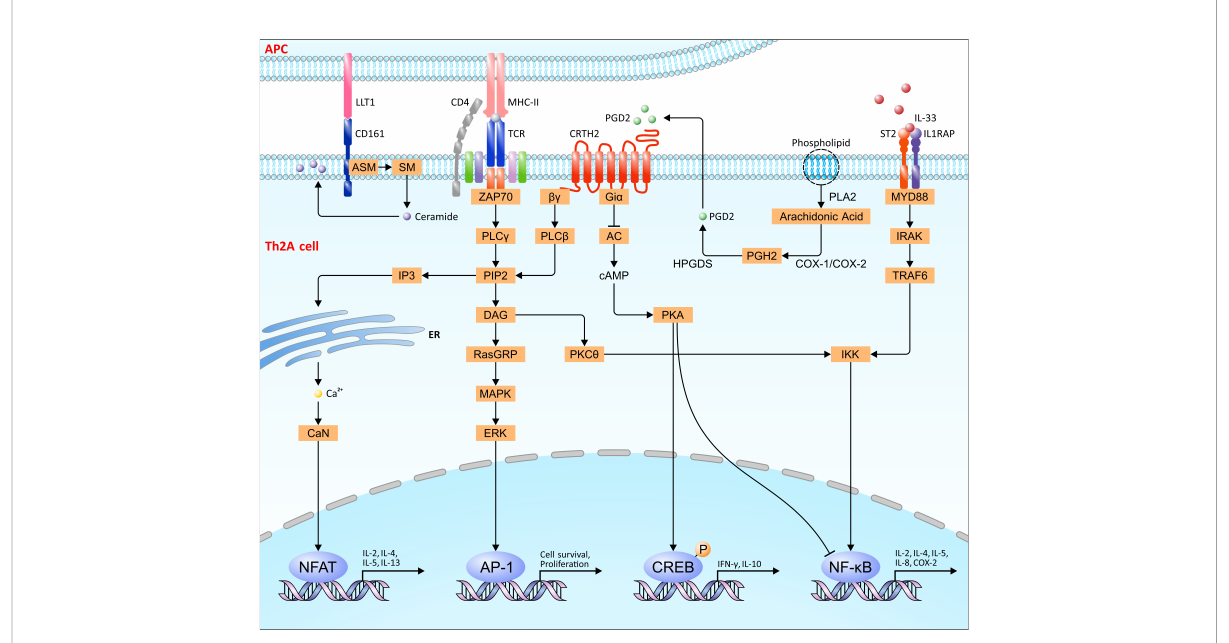
FIGURE 1 The signaling pathway of Th2A cells. The interaction of ST2 with IL-33 recruits MYD88 to activate TRAF6 by IRAK, leading to the activation of NF-kB released from the IKK complex. After CD161 combination with LLT1, aSMase is recruited to catalyze SM into ceramide, resulting in the aggregation in the membrane and inside the cells to mediate distinct functions. CRTH2 activated by PGD2 reduces cAMP production, thereby inhibiting NF- k B activity and phosphorylates CREB protein. Meanwhile, the same as TCR, CRTH2 also activates PKC q , ERK/MAPK, and Ca2 + calcineurin signaling pathways to mediate cell survival, proliferation, and cytokine production through the transcription factor NF- k B, AP-1, and NFAT. Arachidonic acid derived from phospholipids is converted to PGH2 by COX-1/2, which can then be catalyzed into PGD2 by HPGDS. IKK, I k B kinase; ZAP70, z -chain associated protein kinase of 70 kDa; PLC g , phospholipase C g ; PIP2, phosphatidylinositol bisphosphate; DAG, diacylglycerol; PKC q , protein kinase C q ; RASGRP, RAS guanyl nucleotide – releasing protein; MAPK, mitogen-activated protein kinase; ERK, extracellular signal-regulated kinase; IP3, inositol trisphosphate; cAMP, cyclic adenosine 3, 5 ′ -monophosphate; PKA, protein kinase A; COX-1/2, cyclooxygenases I and II; ASM, acid sphingomyelinase; CaN,